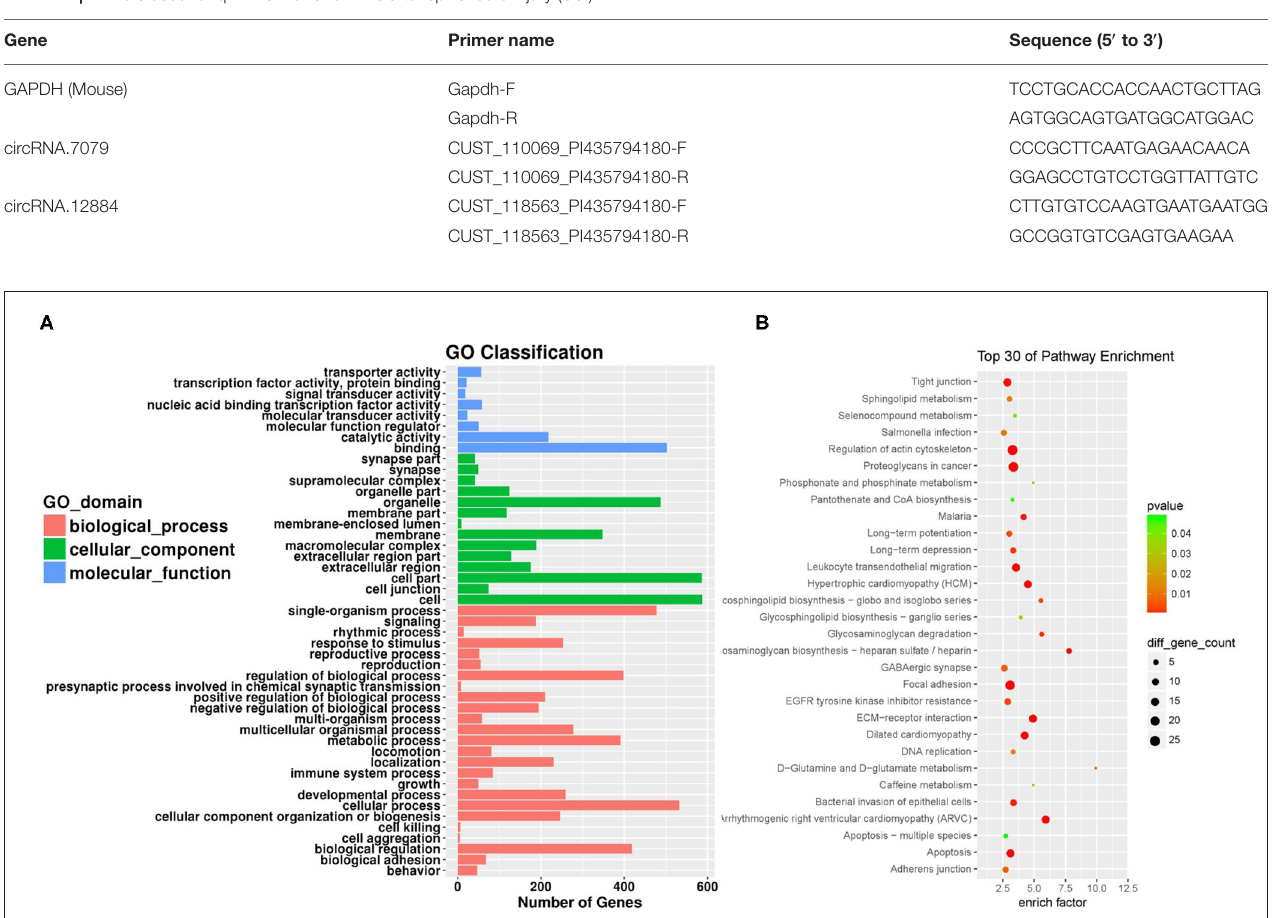
FIGURE 3 | Gene ontology (GO) analysis and Kyoto Encyclopedia of Genes and Genomes (KEGG) pathway annotation of differentially expressed circRNAs. (A) The bar plot shows the major enriched and meaningful GO terms of biological process, cellular component, and molecular function related to the altered circRNAs ranged according to the predicted p -values. (B) The bubble chart shows the top 30 most significantly enriched pathways after SCI. The enrichment factor on the X-axis indicates the specificity of a pathway activating in SCI samples compared with sham samples. The bubble size represents the number of circRNAs enriched in a pathway. Red bubbles indicate a more significant